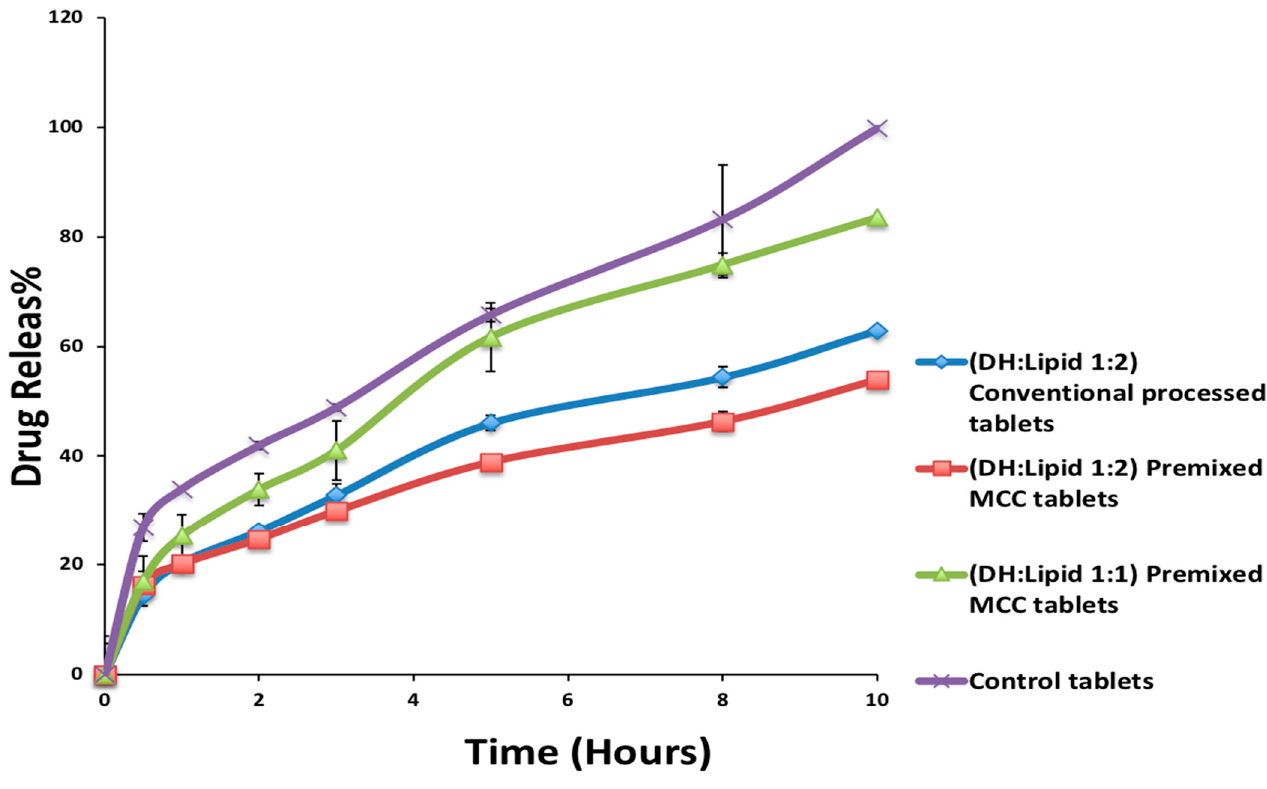
Figure 10. In vitro drug release profile of DH from optimized DH tablets and marketed product (control) (mean ± SD; n = 3).